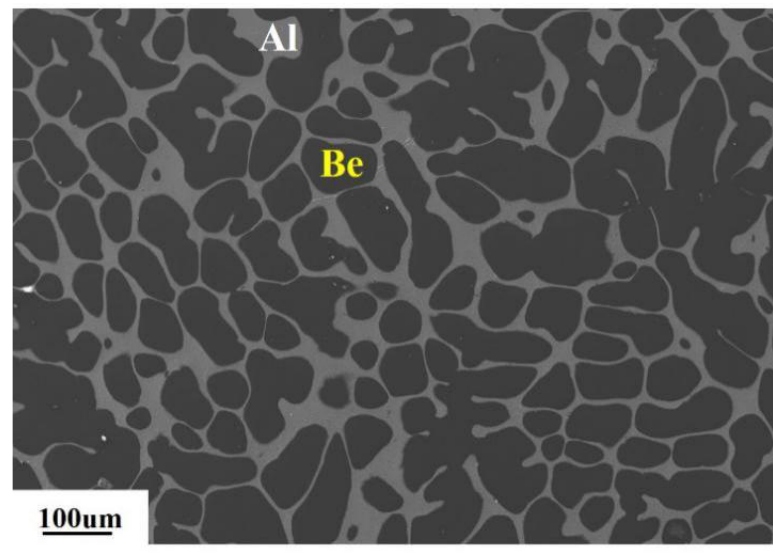
Figure 2. The SEM image of Be-Al alloy.